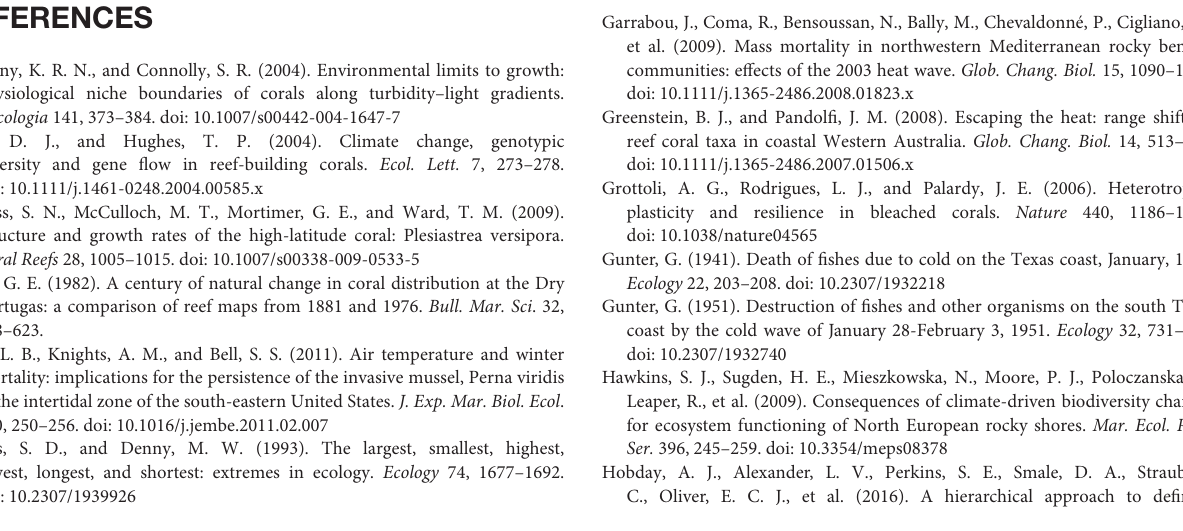
growth which ranges from 1.5–7.8 mm year − 1 (Burgess et